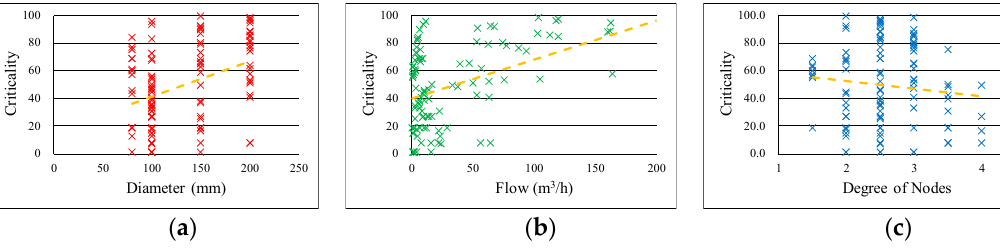
Figure 10. Relation of OVERALL criticality with ( a ) diameter, ( b ) flowrate, and ( c ) DoN pipe for Network 2.